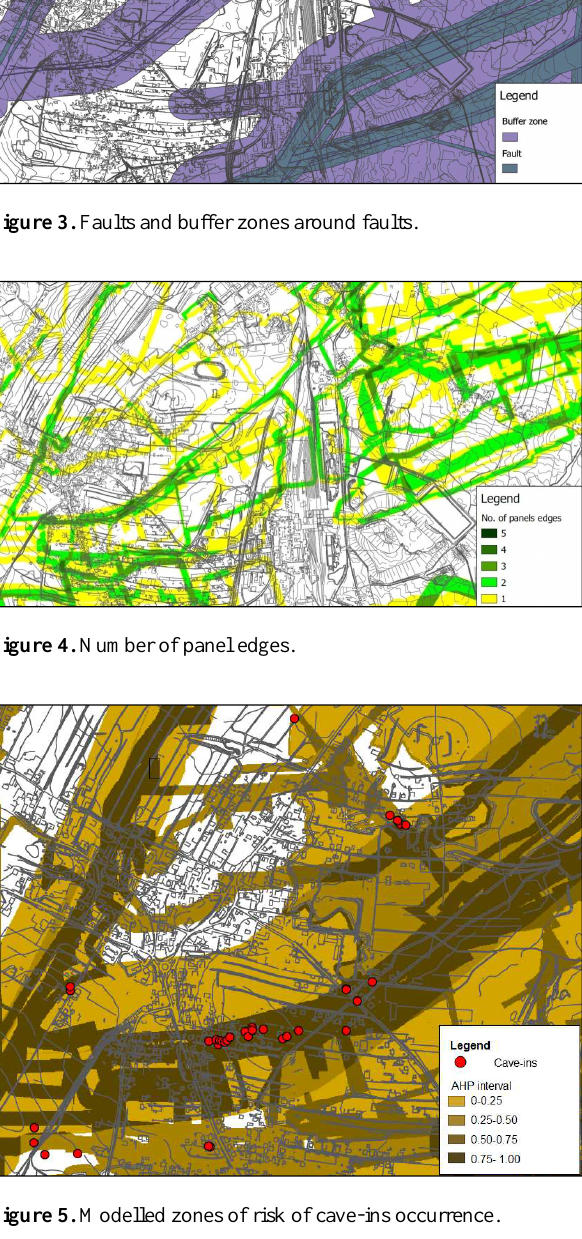
Figure 5. Modelled zones of risk of cave-ins